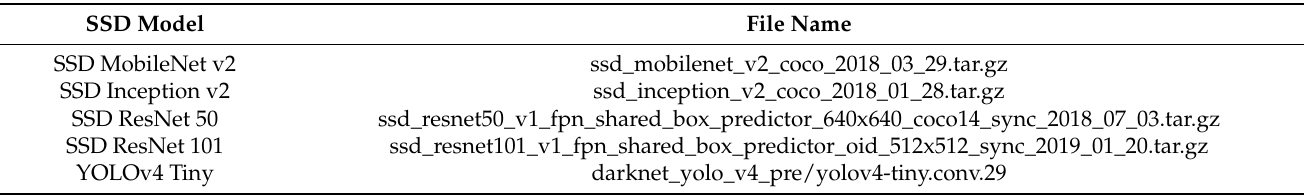
Table A1. Model location in TensorFlow and Darknet databases. All SSD models are in the TensorFlow Models database at http://download.tensorflow.org/models/object_detection/<filename>. YOLOv4 Tiny is in the Darknet database at